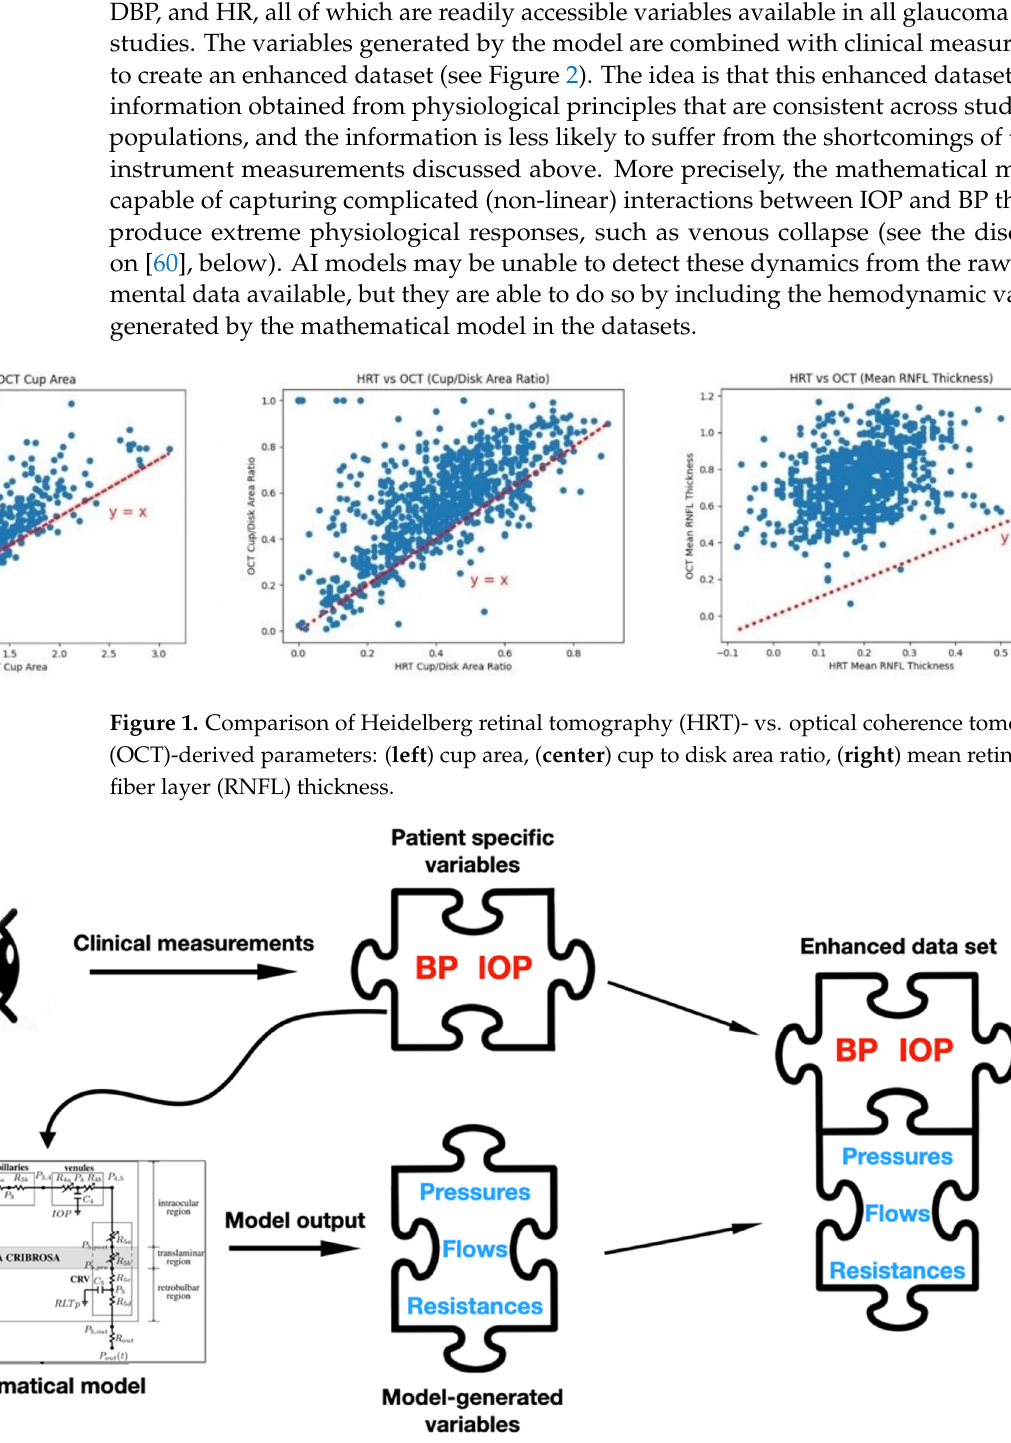
Figure 2. Schematic representation of the data set enhancement process.